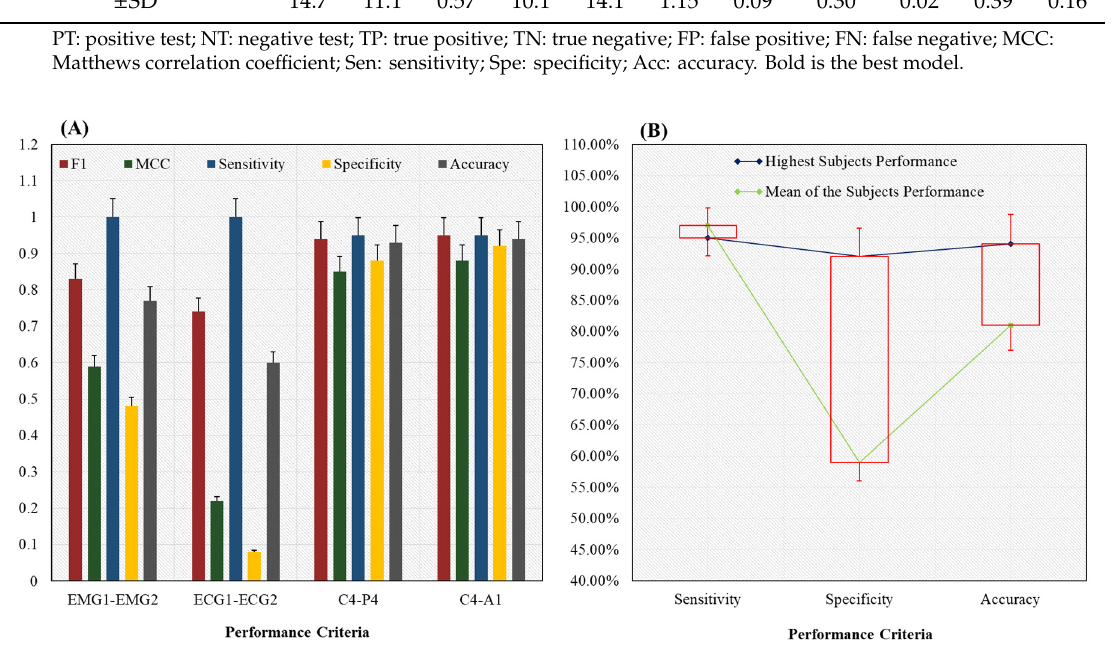
Figure 7. Performance analysis of the subjects (bruxism and healthy) classification using the novel 20-fold HML classifier. ( A ) Comparison between all channels such as EMG1-EMG2, ECG1, ECG2, C4-P4, and C4-A1 channels of the subjects classification. In addition, ( B ) highest and mean performance of the subjects classification. The C4-A1 channel of the EEG signal has the highest accuracy (94%) in the subjects classification.